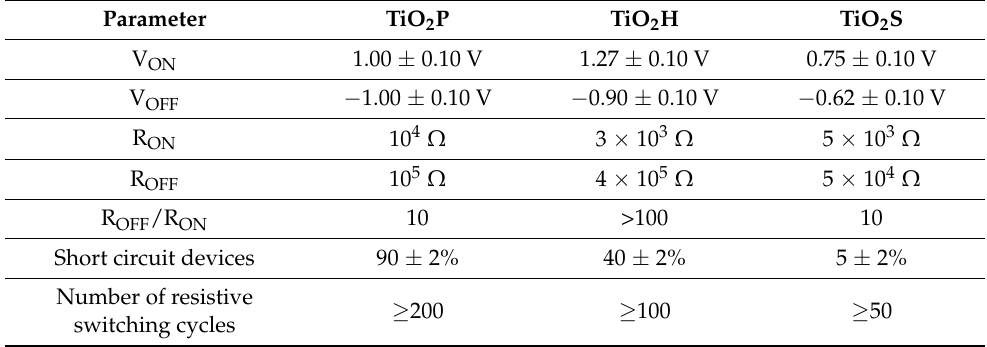
Table 2. The resistive switching parameters for all